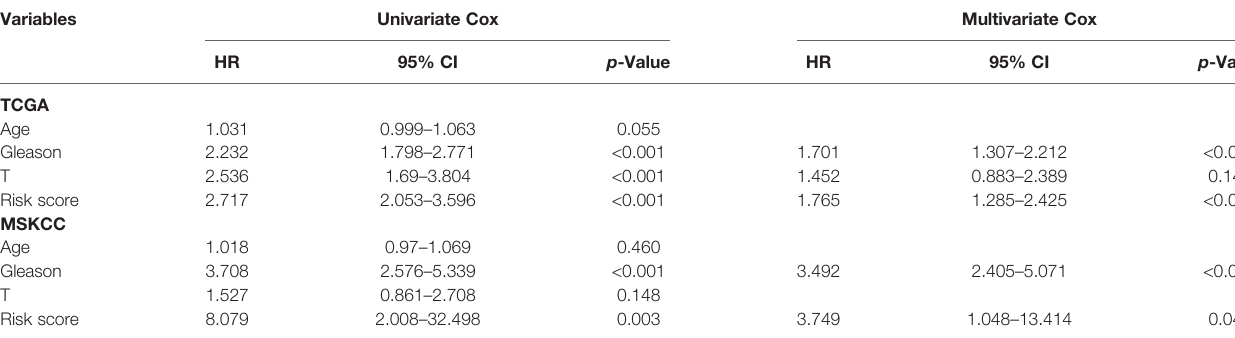
TABLE 2 | Univariate and multivariate Cox regression analysis in TCGA-PRAD and MSKCC cohorts. Variables Univariate